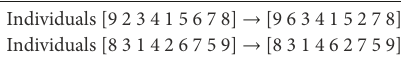
Figure 3: Mutation